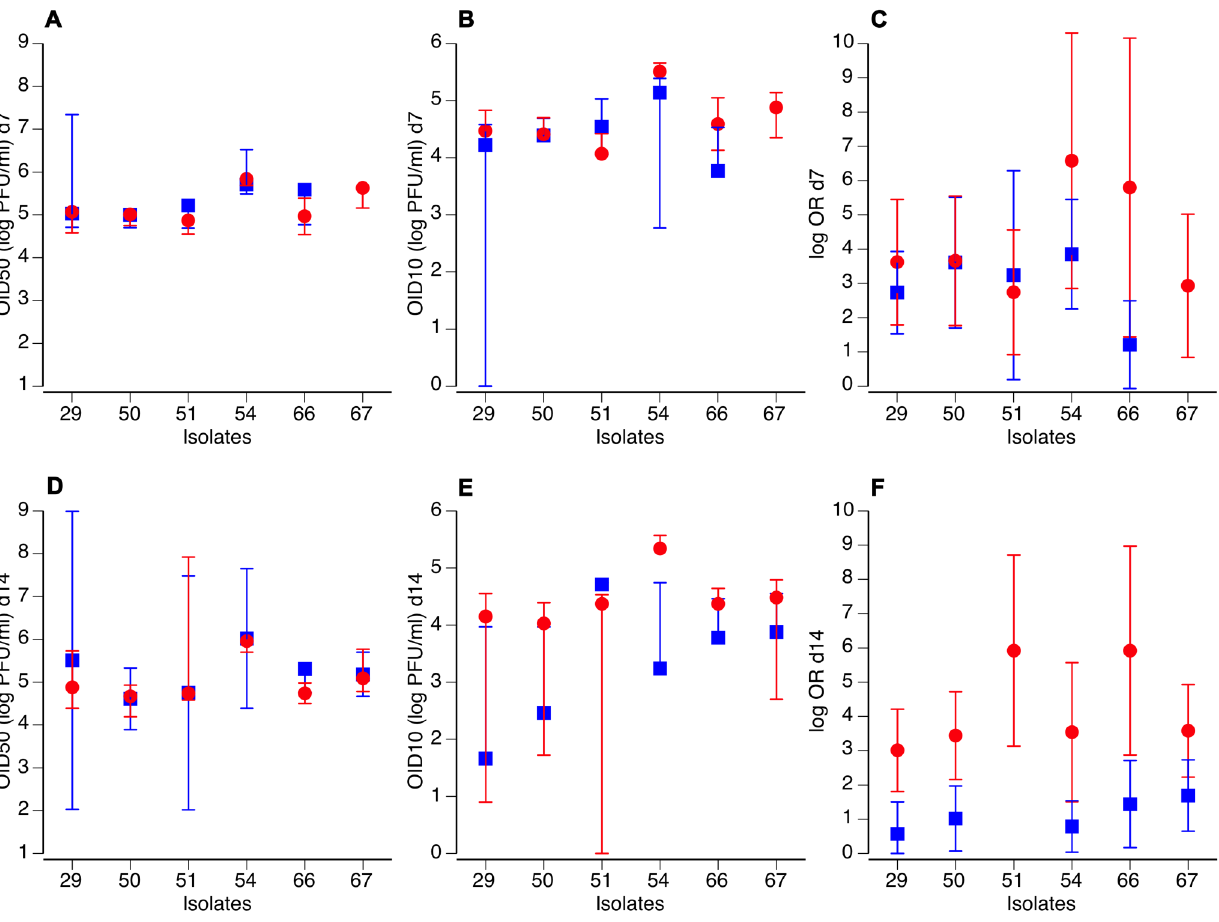
Figure 2. Dose-responses differ between the two Ae.aegypti populations. For both Ae. aegypti populations (blue squares: Na Bo Kham [NB]; red circles: Nakhon Chum [NC]), OID 50 values ( A , D ), OID 10 values ( B , E ) and estimated odds ratios ( C , F ) are shown for each of the six DENV-2 virus isolates. Upper panels ( A – C ) correspond to 7 days and lower panels ( D – F ) to 14 days after the infectious blood meal. Vertical bars indicate 95% confidence intervals of the OID values and standard errors of the odds ratios. Missing error bars mean that they could not be reliably estimated.